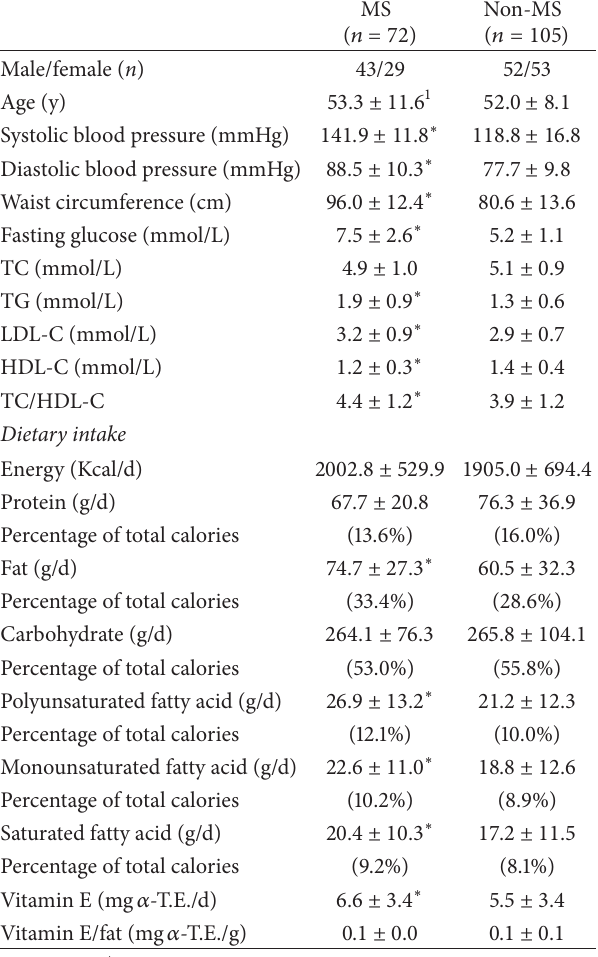
Table 1: Characteristics of subjects. Table 2: The odds ratios of metabolic syndrome based on the antioxidant enzymes